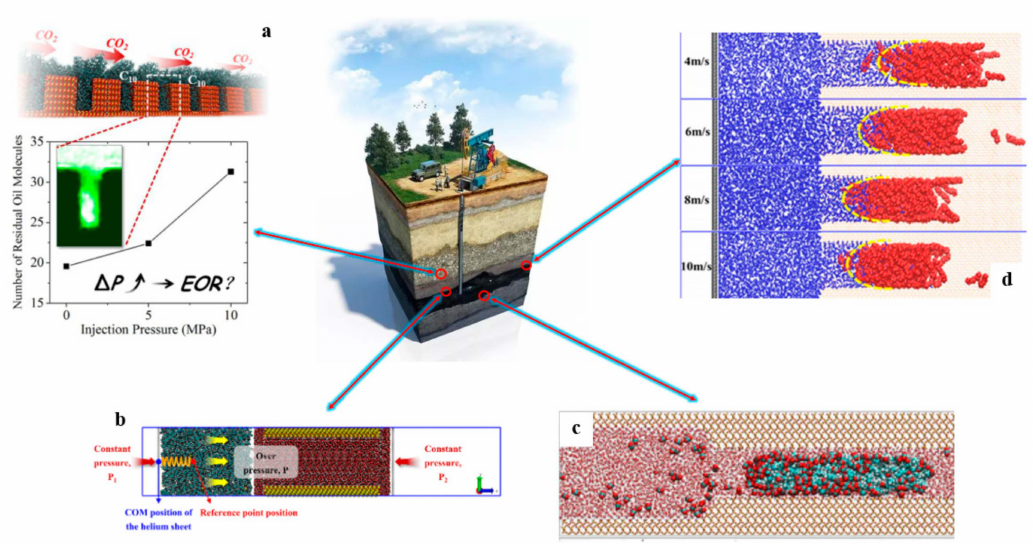
Figure 8. Schematic representation summarizing some upstream hydrocarbon industry systems investigated within the molecular modeling framework. ( a ) principle of carbon dioxide oil displace- ment; ( b ) initial model of the quartz nano-pore throat system and schematic diagram of the steered molecular dynamics simulation; ( c ) typical snapshots of process of with 200 CO 2 molecules at 5 ns; and ( d ) snapshots of the meniscus curvature at the same injection volume of CO 2 but different injection rates of 4, 6, 8 and 10 m/s